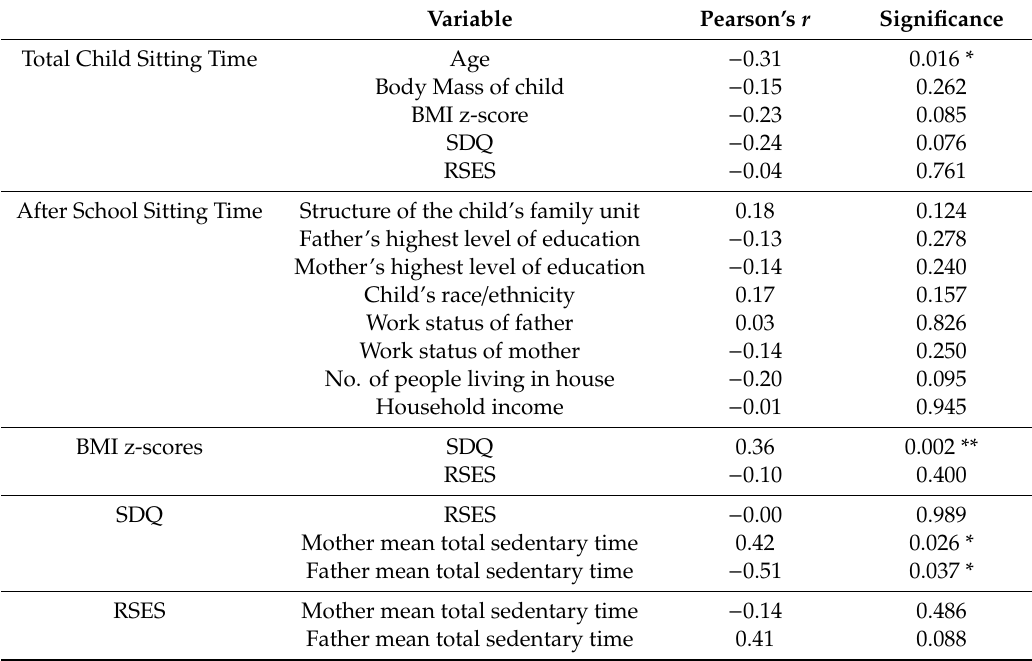
Table 5. Associations between child sitting time, sociodemographic and psychosocial